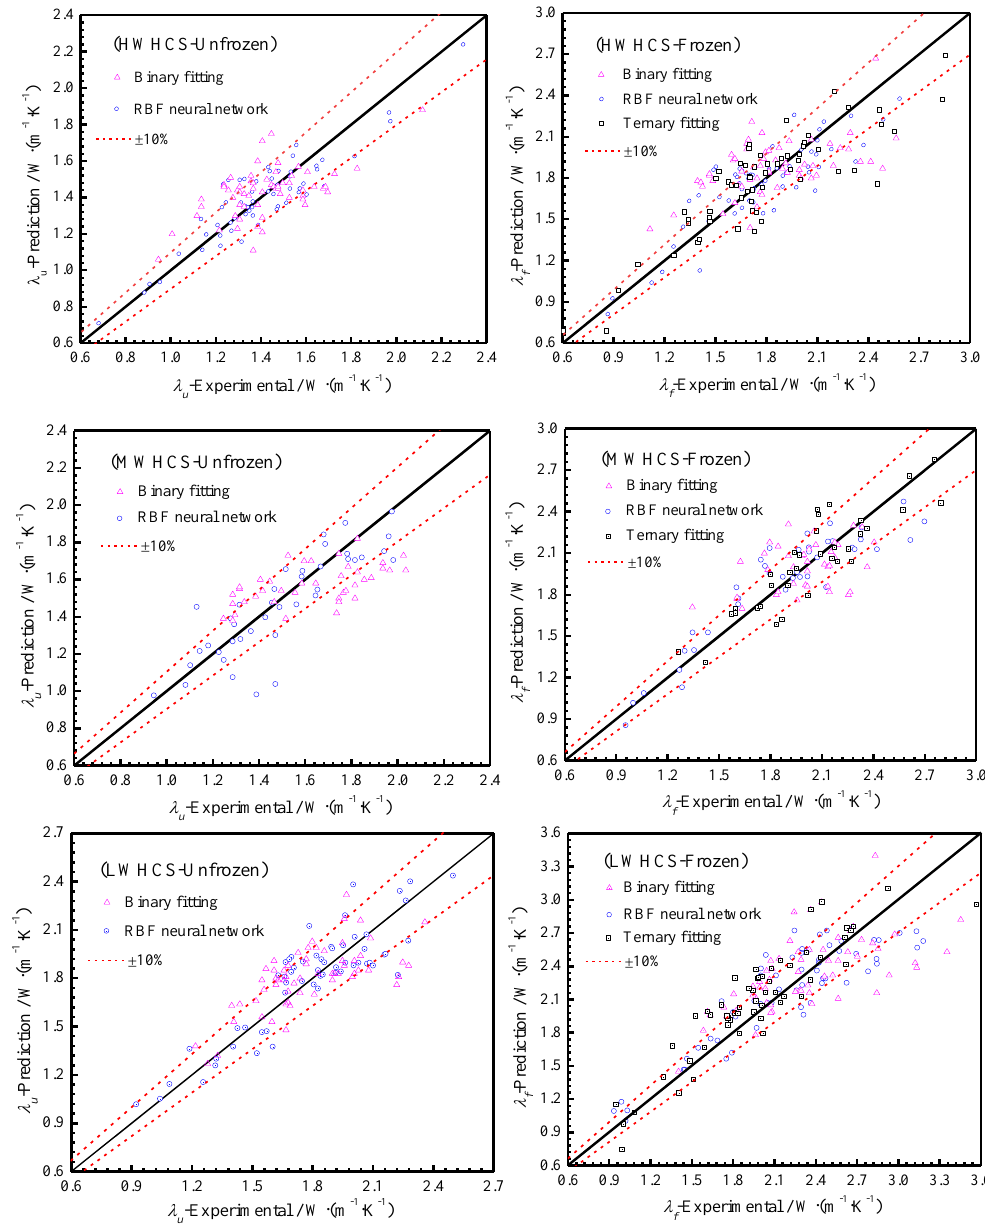
Figure 13. Predictive results of three prediction models.